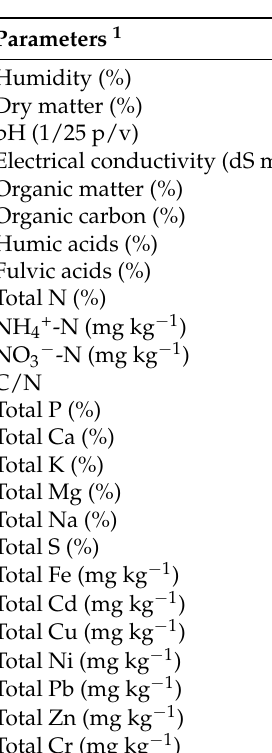
Table 1. Characteristics of the SMS applied to the